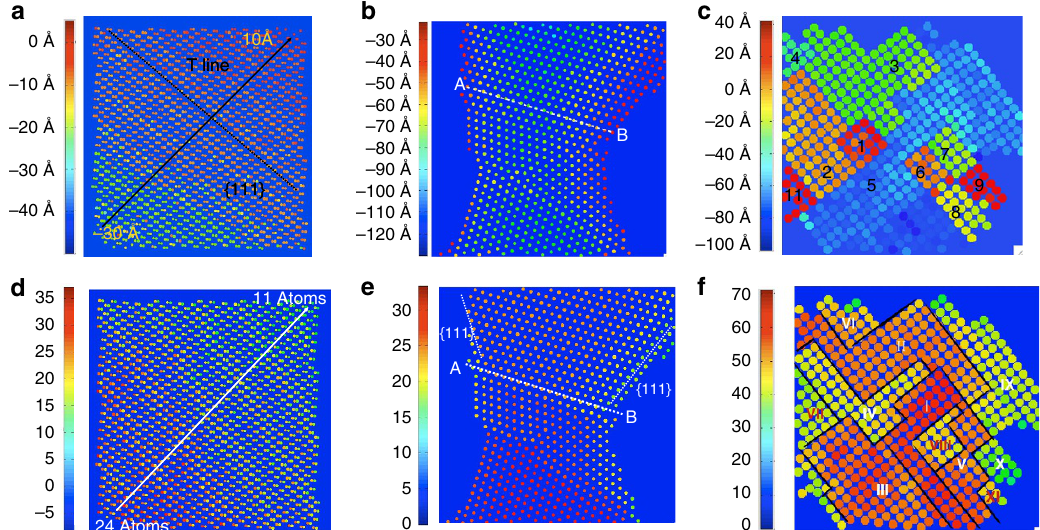
Figure 8 | Focus maps and mass maps. ( a ) Focus map for Ge. ( b ) Focus map for Au bridge. ( c ) Focus map for MgO, which shows focus patches that correspond to the peaks indicated in the histogram (fig. 3c). ( d ) Mass map for Ge. ( e ) Mass map for Au bridge. ( f ) Mass map for MgO. The humps indicated in the mass histogram of MgO (fig. 3c) corresponds to the mass patches. NATURE COMMUNICATIONS|7:10603|DOI: